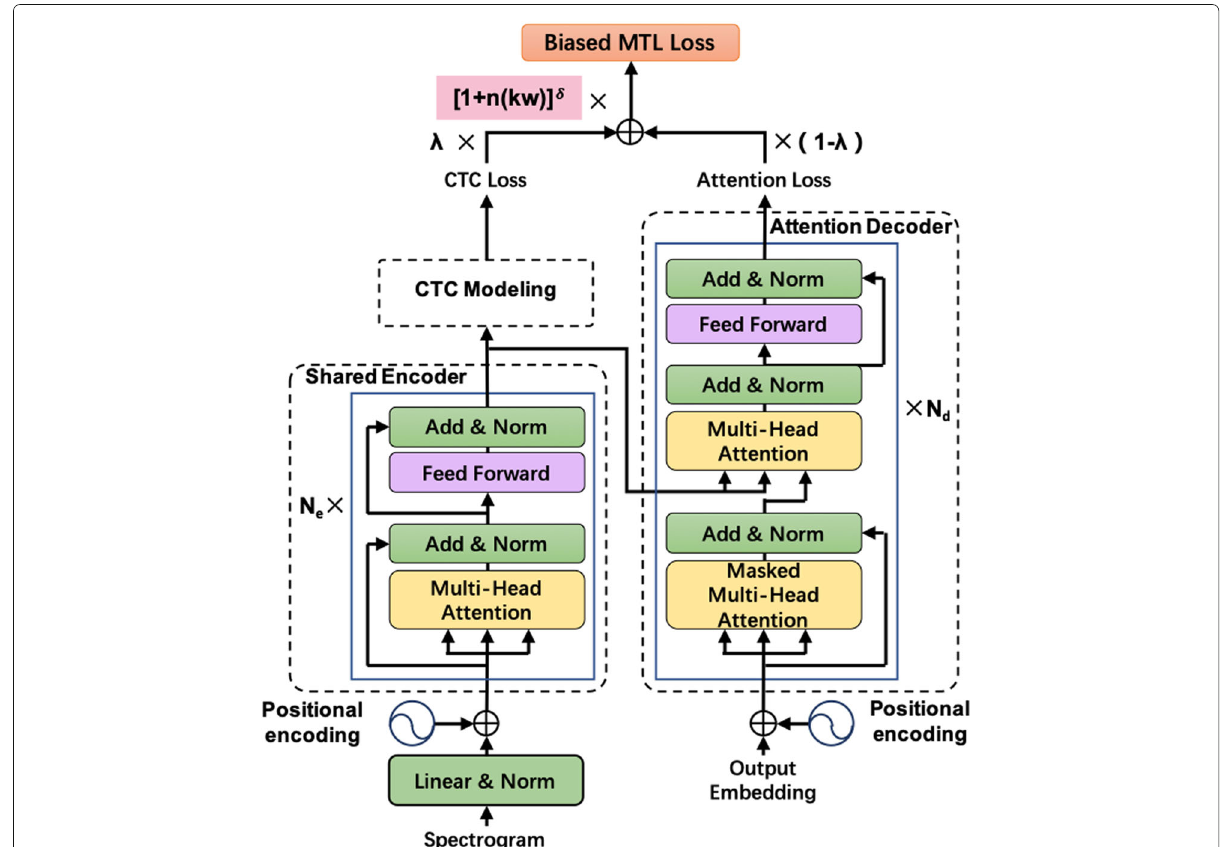
Fig. 4 An overview of our biased-loss ASR front-end based on Transformer [11]